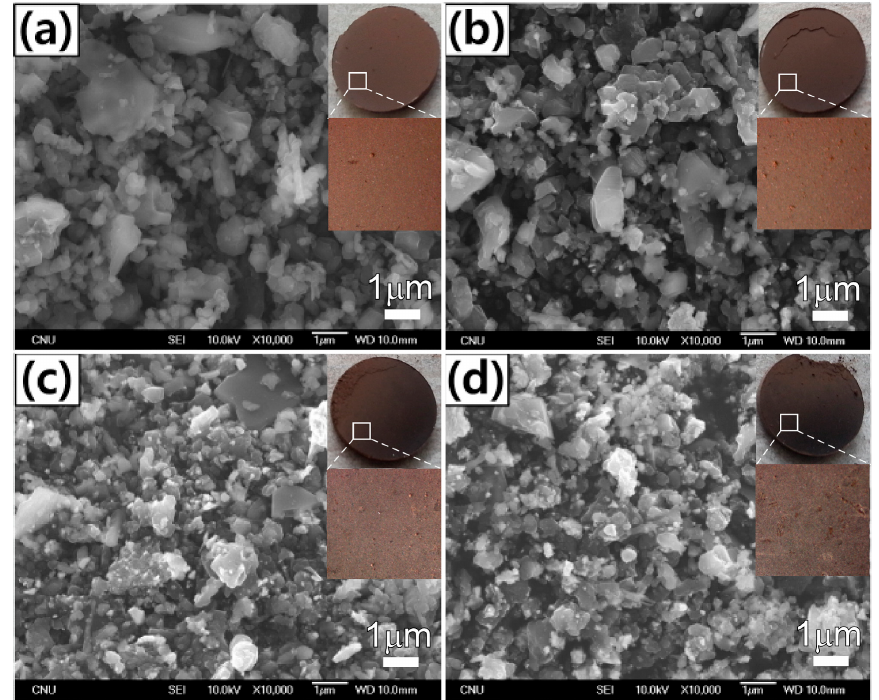
Figure 3. Scanning electron microscopy (SEM) images of the wet milled boron particles with milling operation times of: ( a ) 0 h; ( b ) 2 h; ( c ) 4 h; and ( d ) 8 h. The insets show the corresponding photograph and optical microscope images of the pelletized samples. Table 1. Summary of atomic compositions (%) of wet milled boron particles at various milling times.